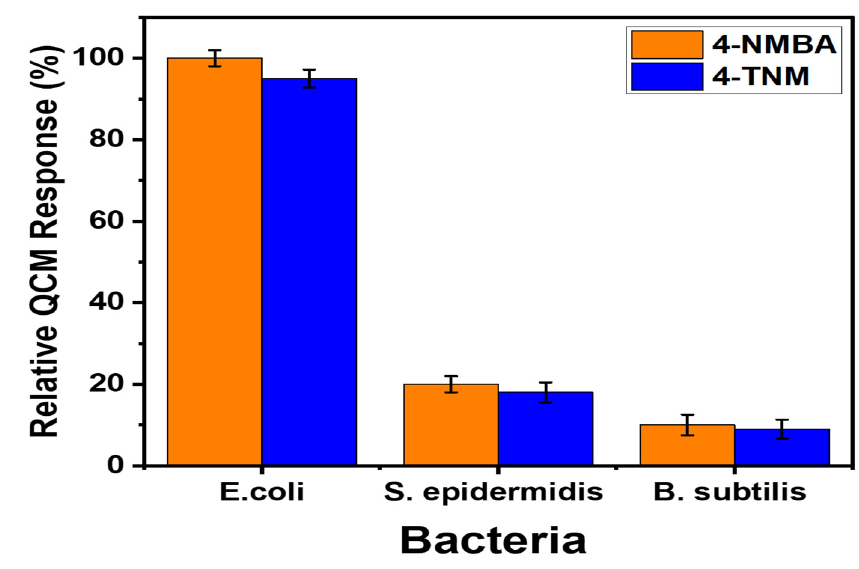
Figure 7. Selectivity for E. coli compared to S. epidermidis and B. subtilis